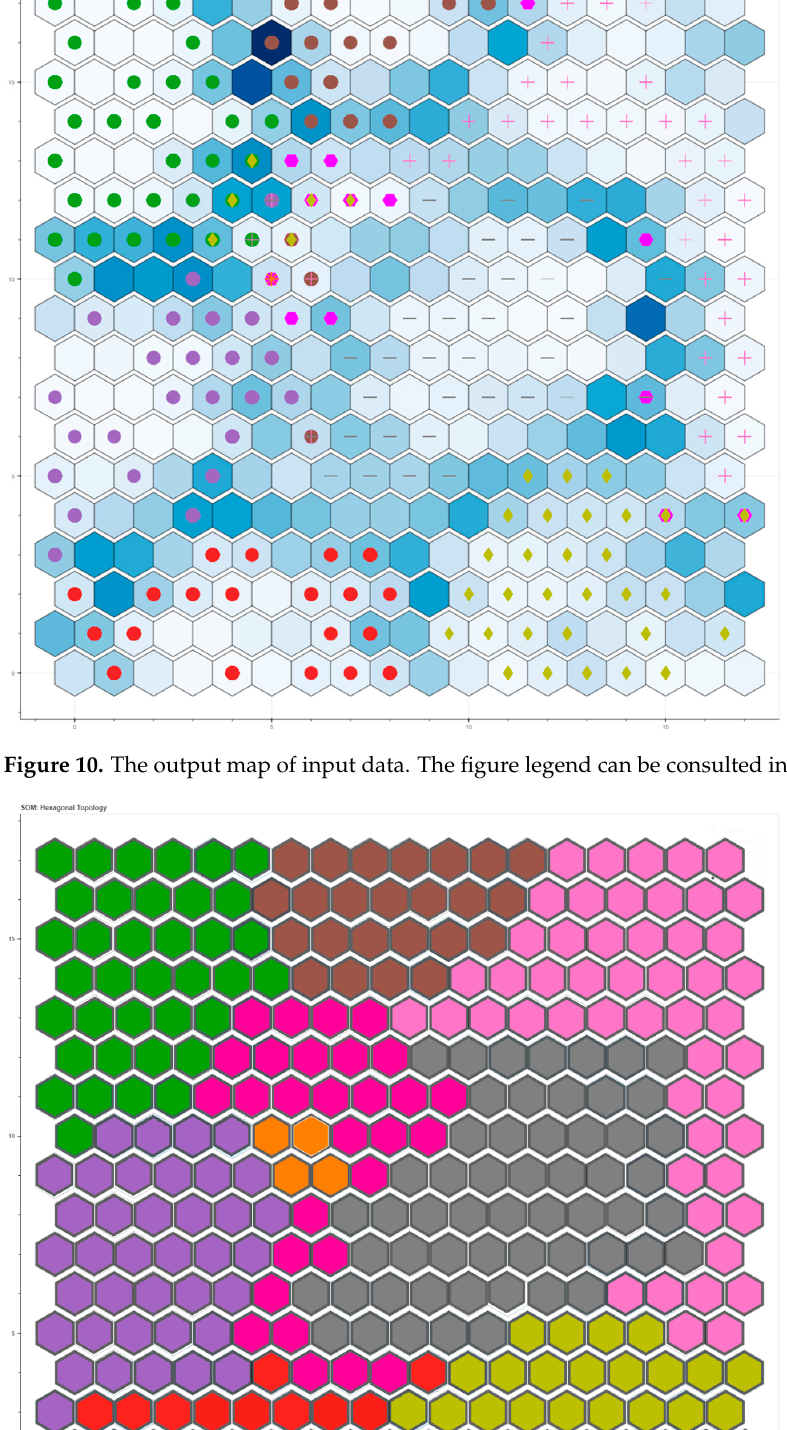
Table 4. Legend of SOM output map.